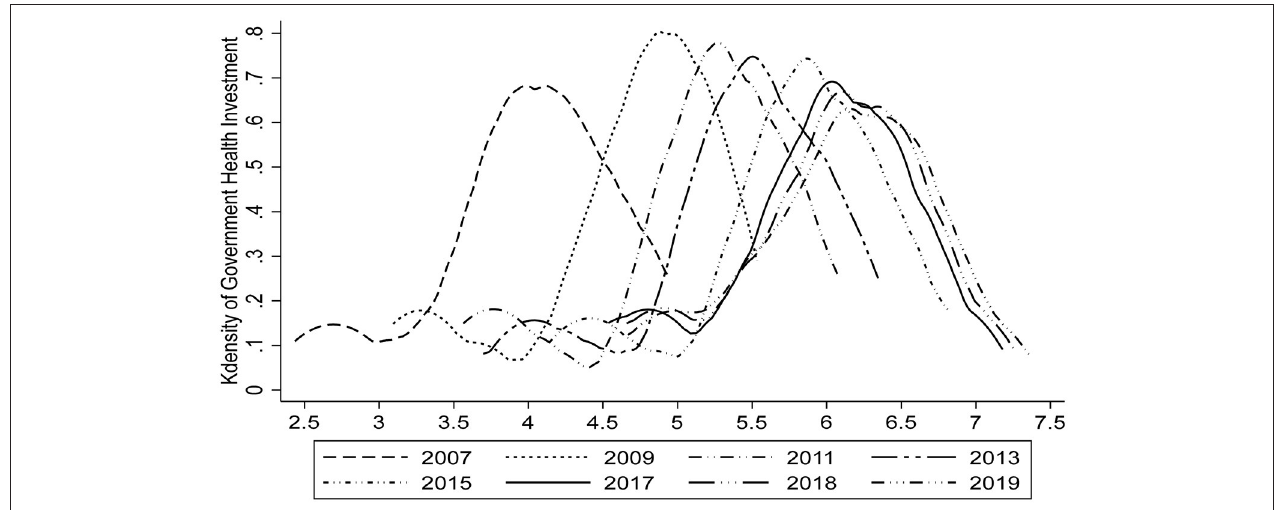
FIGURE 2 | Kdensity plot of government health investment.